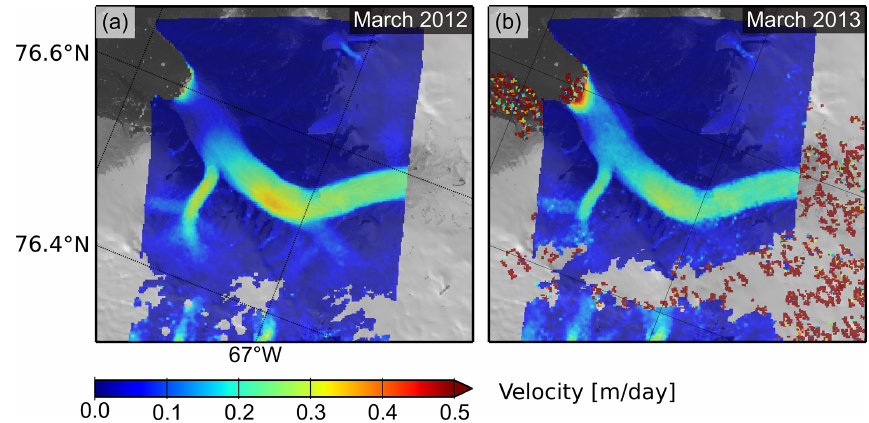
Figure 10. Exemplary velocity fields during a quiescent phase in March 2012 and 2013. The background image is a Landsat 8 scene (USGS, 2019). The colour scale is different from that in the previous figures.